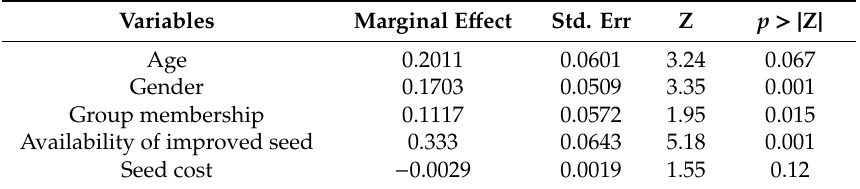
Table 9. Marginal e ff ects on determinants of adoption of improved groundnut